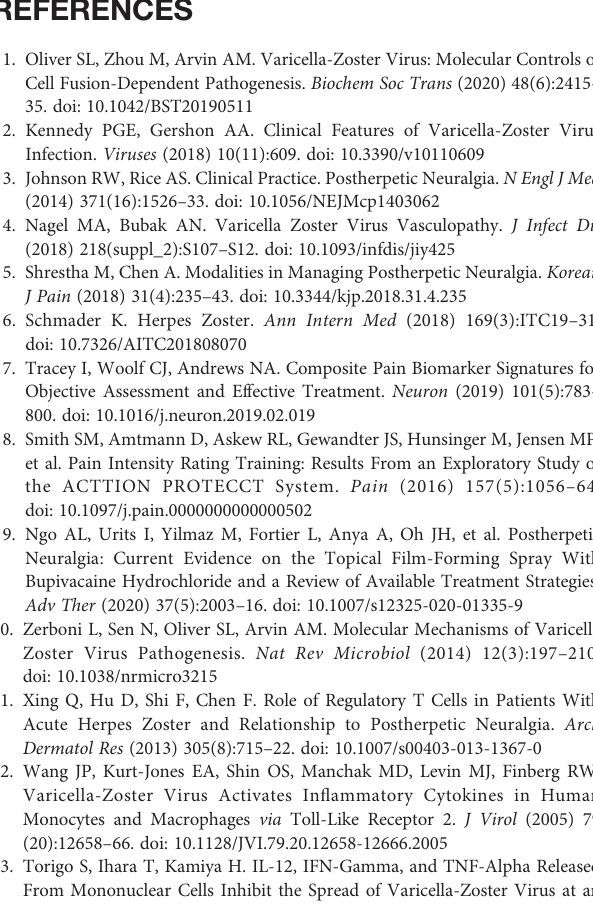
Supplementary Figure 2 | Dynamic signatures of immune subsets in HZ patients at different time point after the onset of rash (related to Figure 2 ). (A) Boxplots revealing the dynamic characteristics of immune subsets as shown in .